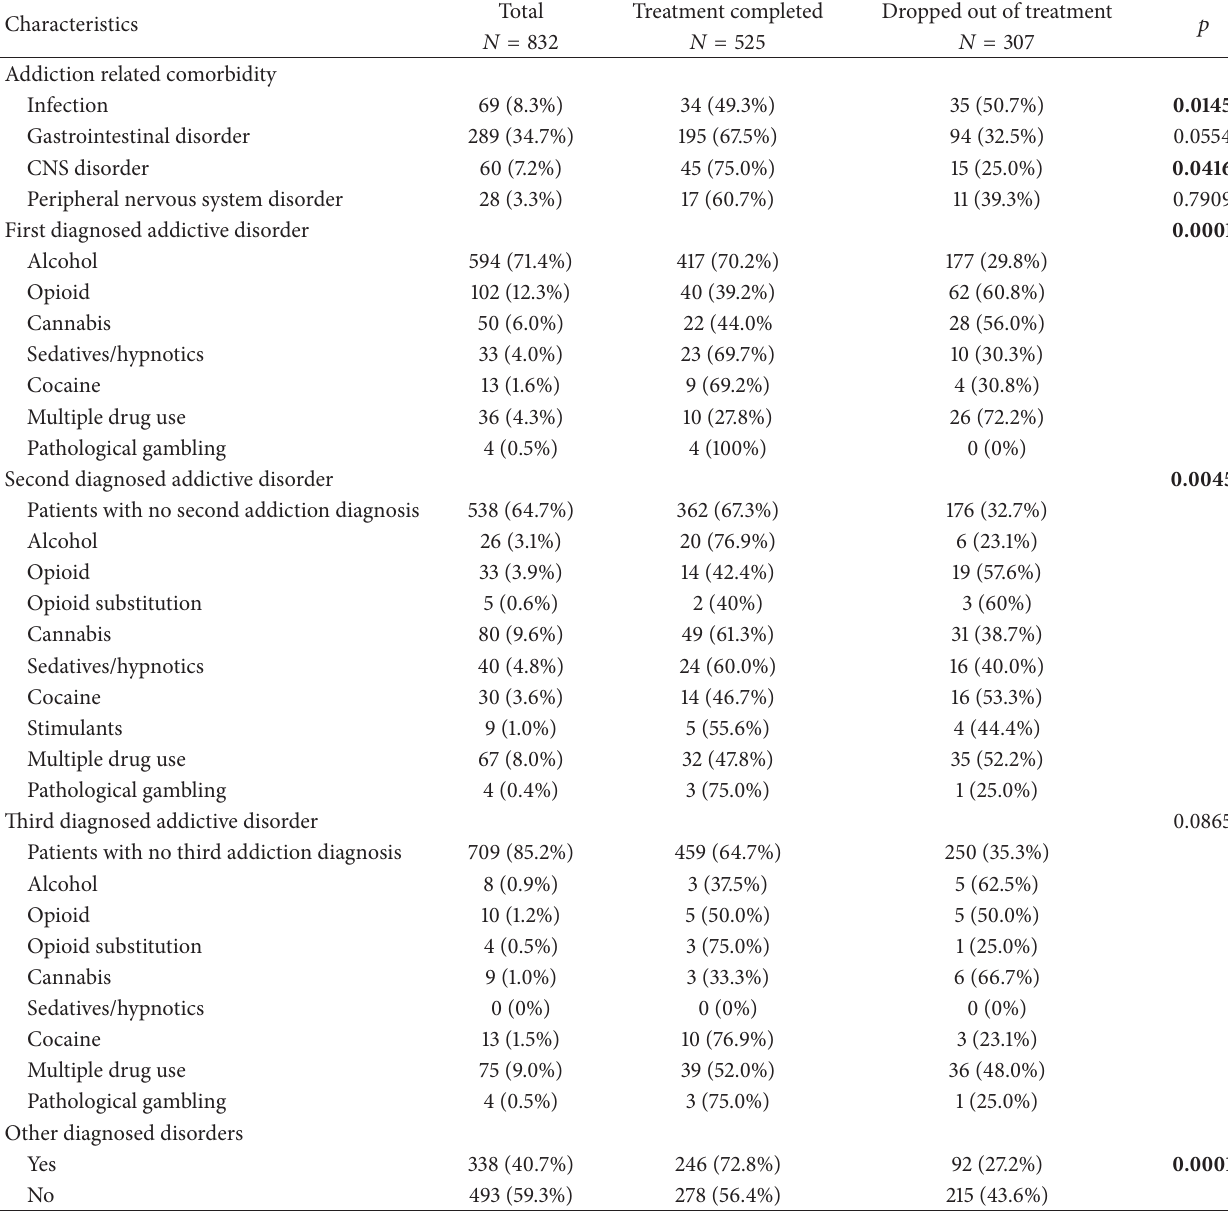
(a) Results of likelihood Chi square test for medical determinants of premature treatment